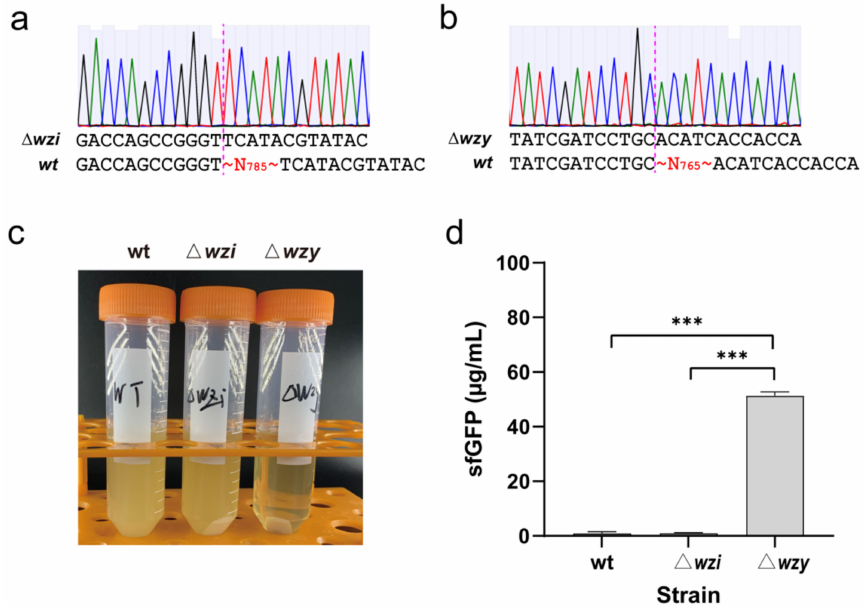
Figure 2. Deletion of the genes ( a ) wzi and ( b ) wzy from the genome of K. pneumoniae KP_1.6366. Both disrupted gene sequences were confirmed by DNA sequencing. ( c ) Cell collection of three strains by centrifugation at 12,000 g for 10 min. ( d ) Cell-free synthesis of sfGFP using cell extracts prepared from the wild-type (wt), ∆ wzi , and ∆ wzy strains. Values show means with error bars representing standard deviations (s.d.) of at least 3 independent experiments. Student’s t -tests were used for statistical analysis, and p < 0.05 indicated statistical significance (*** p <